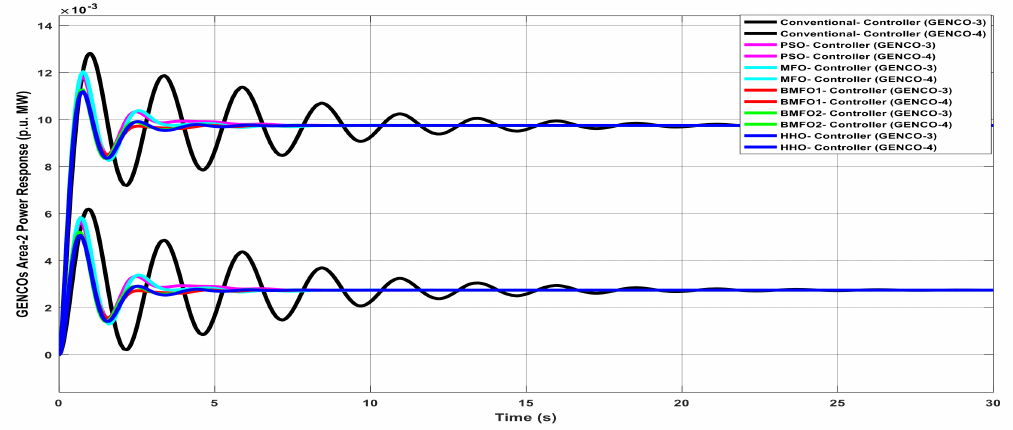
Figure 20. GENCOs generation response of Area2 with various controllers under contract violation case.